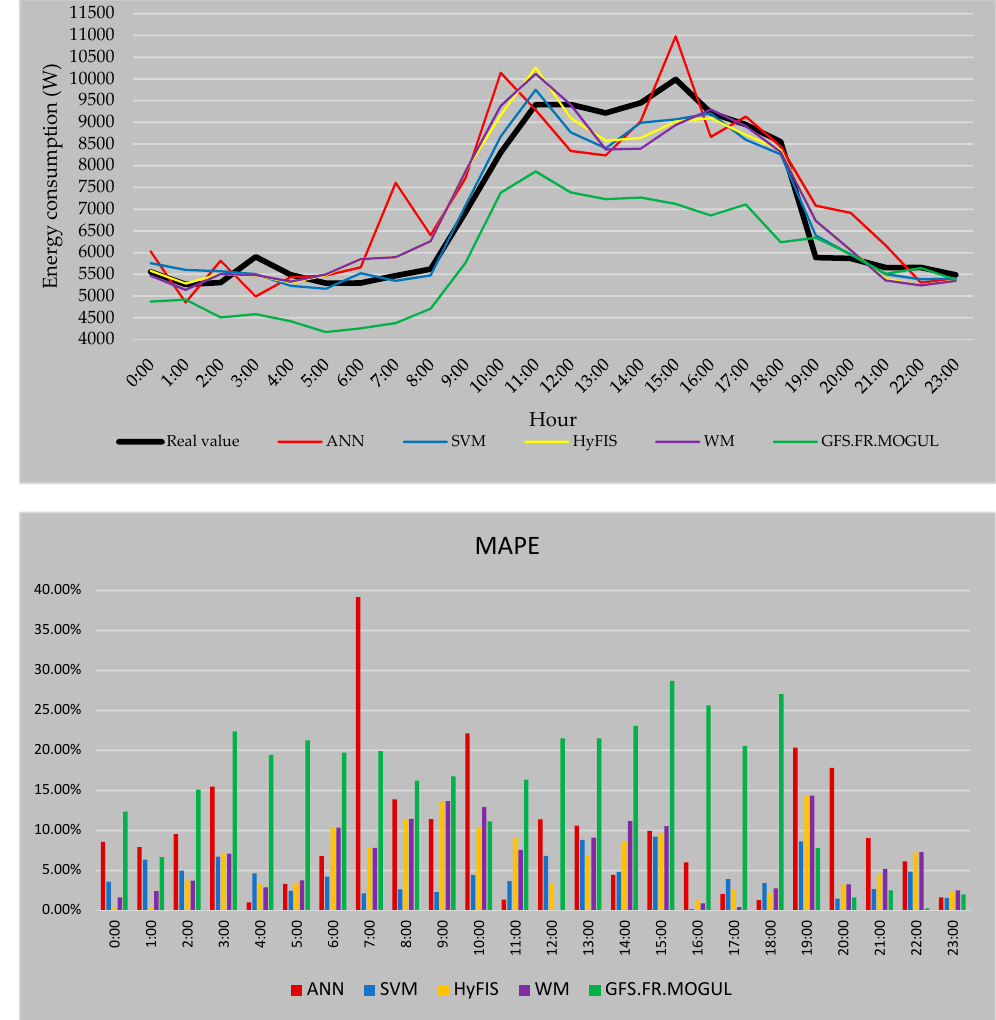
Figure 14. Forecasted values and errors for building N using the 3rd data preparation strategy.